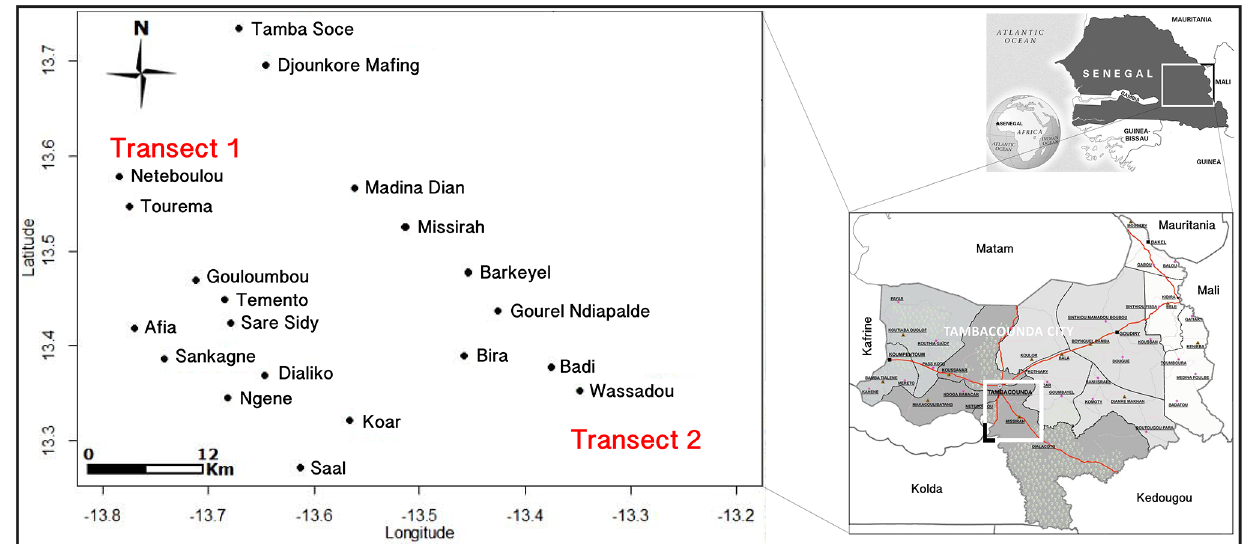
Figure 1. Localisation of the study sites.